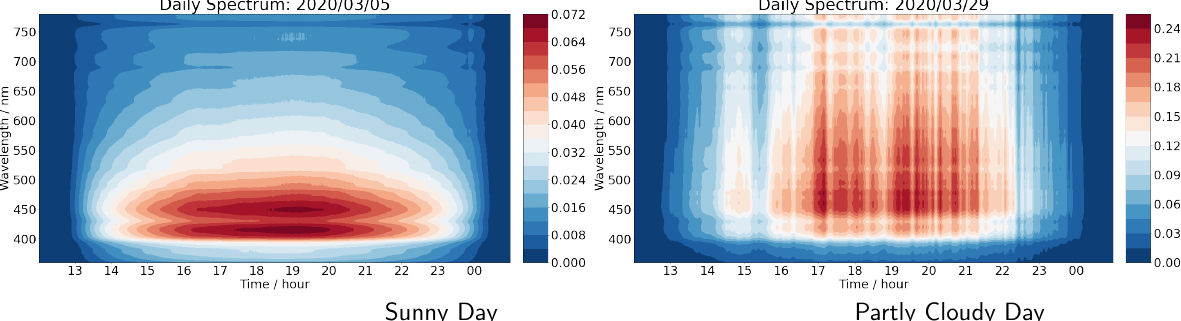
Figure 12. A comparison of the wavelength ( y -axis) and UTC time ( x -axis) resolved daily spectra for a sunny day on the left and for a cloudy day on the right. The color denotes the solar irradiance in unit W/m 2 /nm. Both spectra were collected using the Minolta CL-500A Illuminance Spectrophotometer.